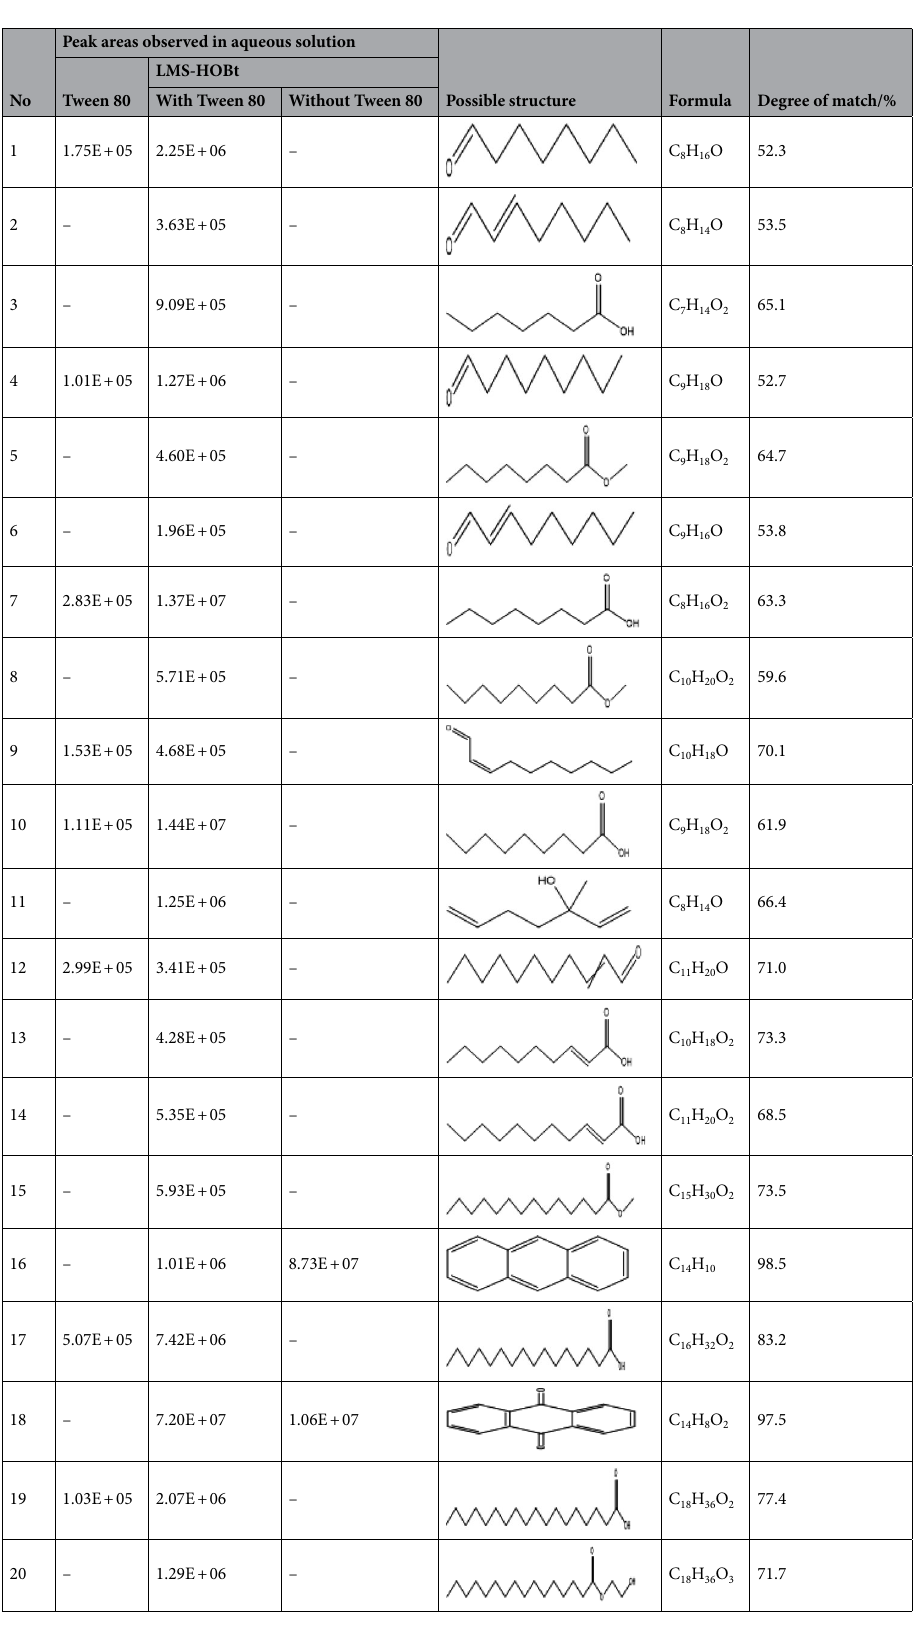
Table 2. Information of peak at the same time by possible products in both systems. Peak areas observed by GC/MS and possible formula of products produced with or without Tween 80 in LMS-HOBt and Tween